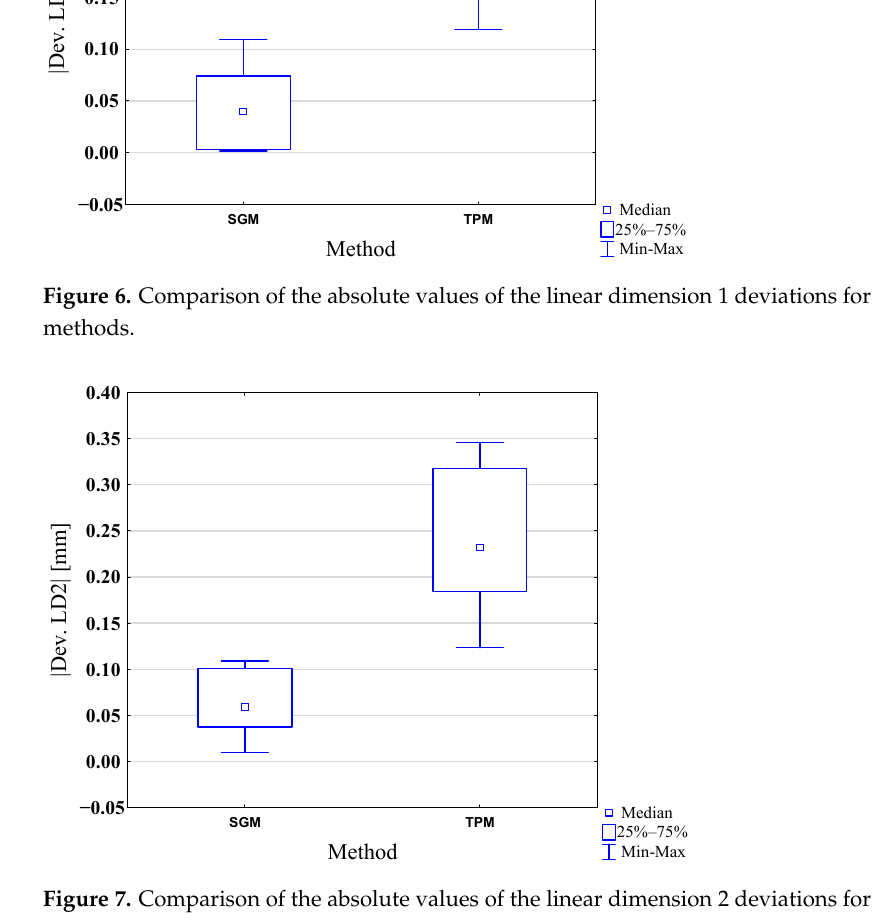
Figure 7. Comparison of the absolute values of the linear dimension 2 deviations for SGM and TPM methods.